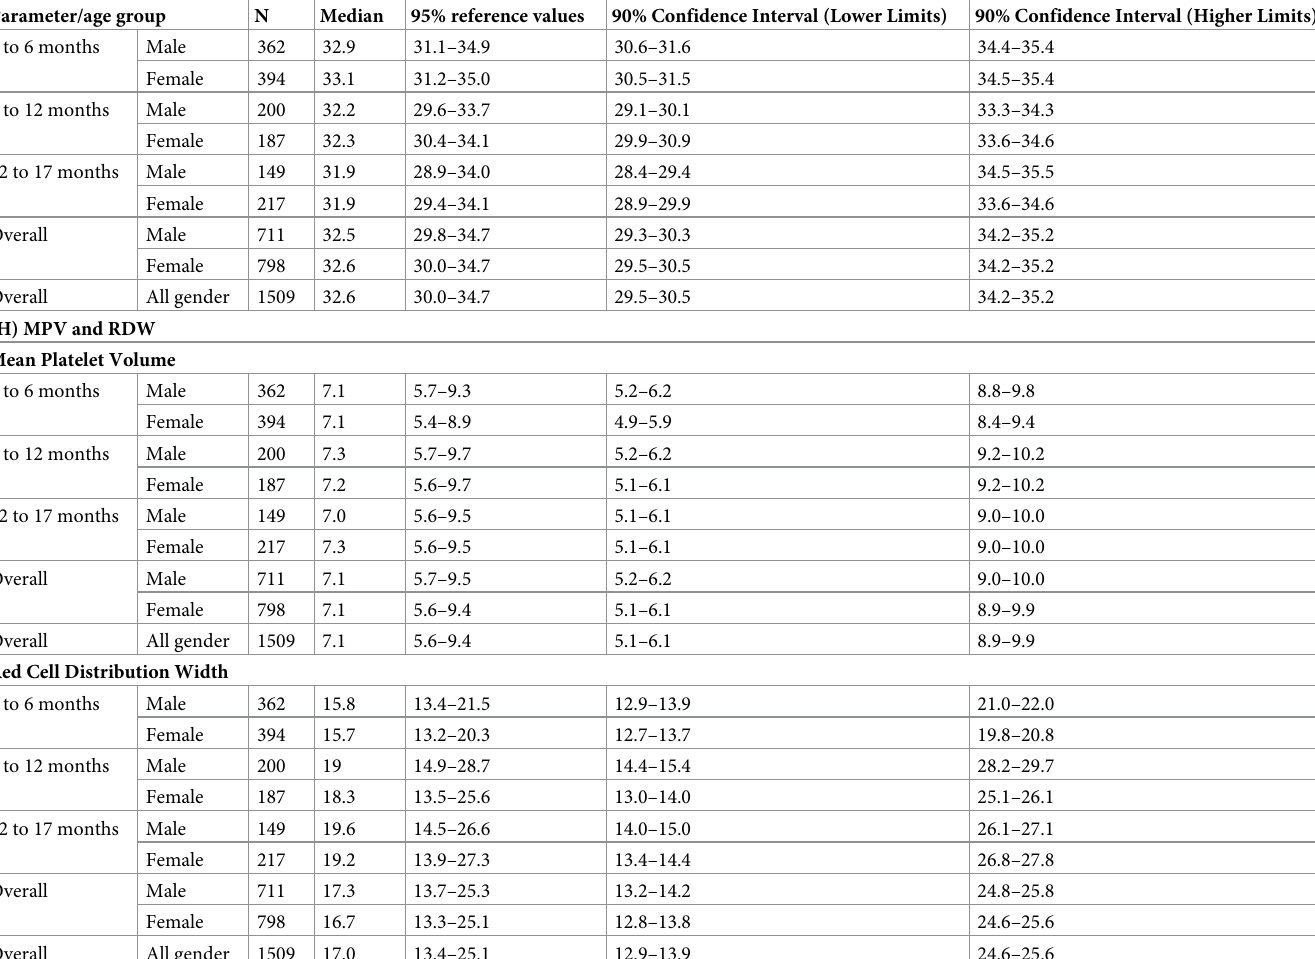
The results in this table show 95% reference values for granulocyte absolute counts and MCHC in different age categories and 90% confidence intervals stratified by gender. The results in this table show 95% reference values for MPV and RDW in different age categories and 90% confidence intervals stratified by gender.